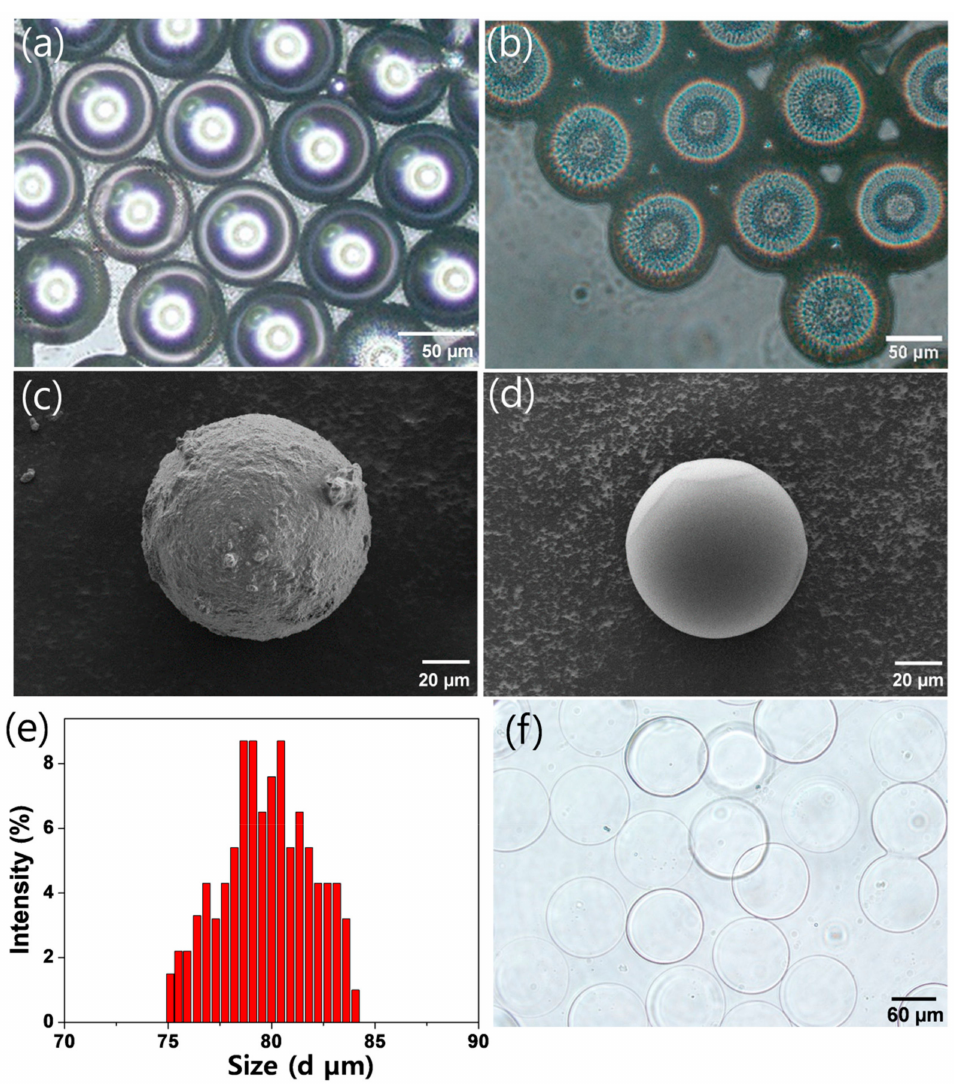
Figure 2. Microscopic images of ( a ) emulsified hydrogel precursor droplets and ( b ) PEG-amine microbeads after destabilization. Scanning electron microscopic (SEM) images of ( c ) PEG-amine microbeads and ( d ) non-functionalized PEG microbeads. ( e ) Size distribution of PEG-amine microbeads (100 ea) and ( f ) microscopic image of PEG-amine microbeads swollen in